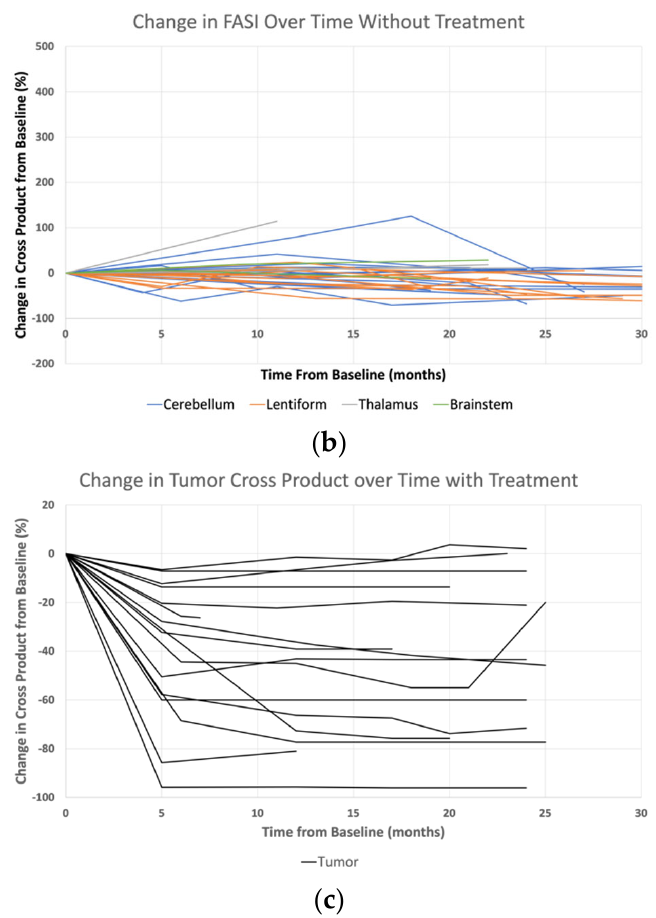
Figure 1. Spider plots demonstrating the percent c hange in the cross product of lesions from the baseline. Change in FASI from the chosen anatomic locations are shown on treatment with selu ‐ metinib ( a ) and without treatment ( b ) with variable responses. Treatment of LGG with selumetinib showed a consistent decrease over time ( c ).